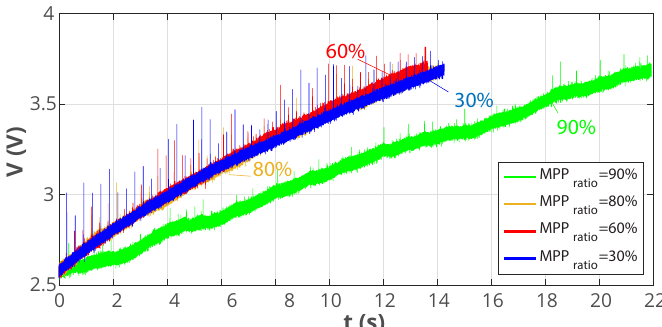
Figure 12. Bus voltage during switching interval for different MPPT ratios.